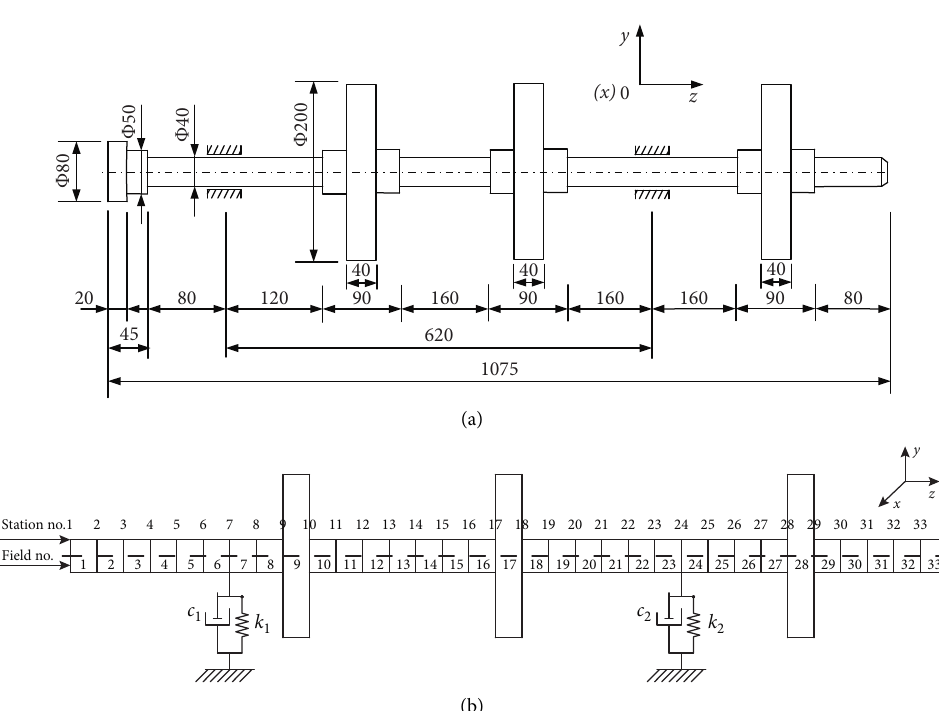
Figure 2: The model of a rotor system: (a) a bearing-rotor system with three discs; (b) the TMM model.